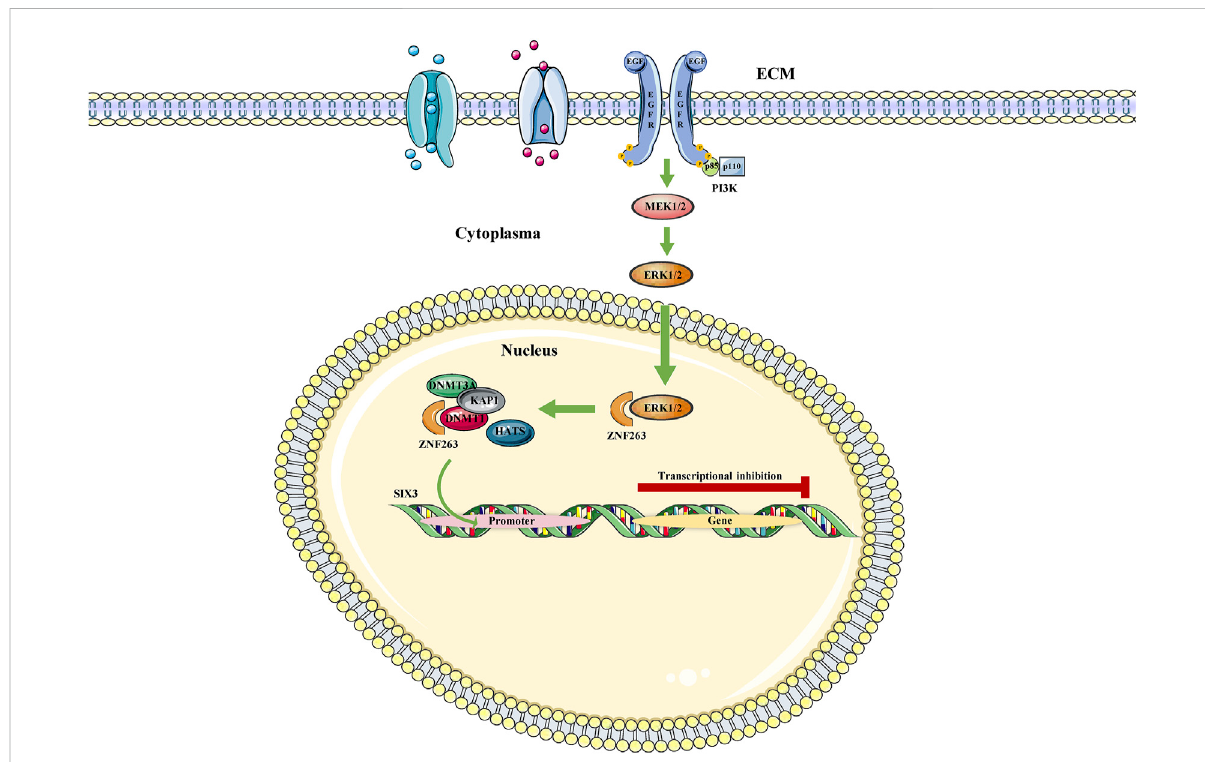
FIGURE 2 MAPK/ZNF363/DNMTs/SIX3 signaling pathway. The MAPK signaling pathway represses SIX3 transcription by regulating ZNF263, a repressor gene of Six3, in the